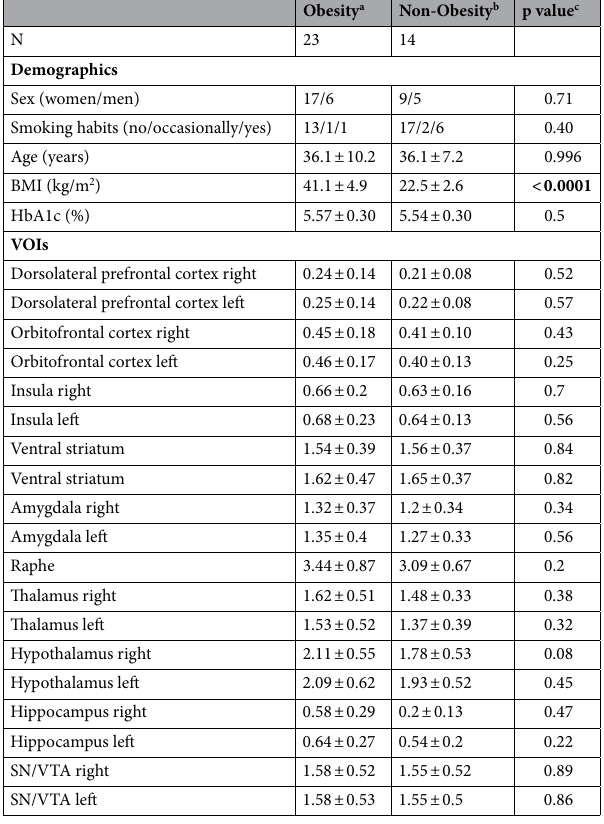
Table 1. Demographics and 5-HTT BP ND from volume-of-interest (VOI) analysis obtained with [ 11 C]DASB and PET. SN substantia nigra, VTA ventral tegmental area. Bold value indicates statistically significant group differences (p < 0.05). a BMI > 35 kg/m 2 . b BMI < 27 kg/m 2 . c Student’s t-test except for sex and smoking habits (Fisher’s Exact test).